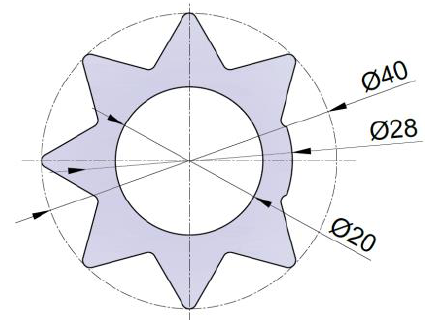
Figure 1. The trimmed star-shaped fin.